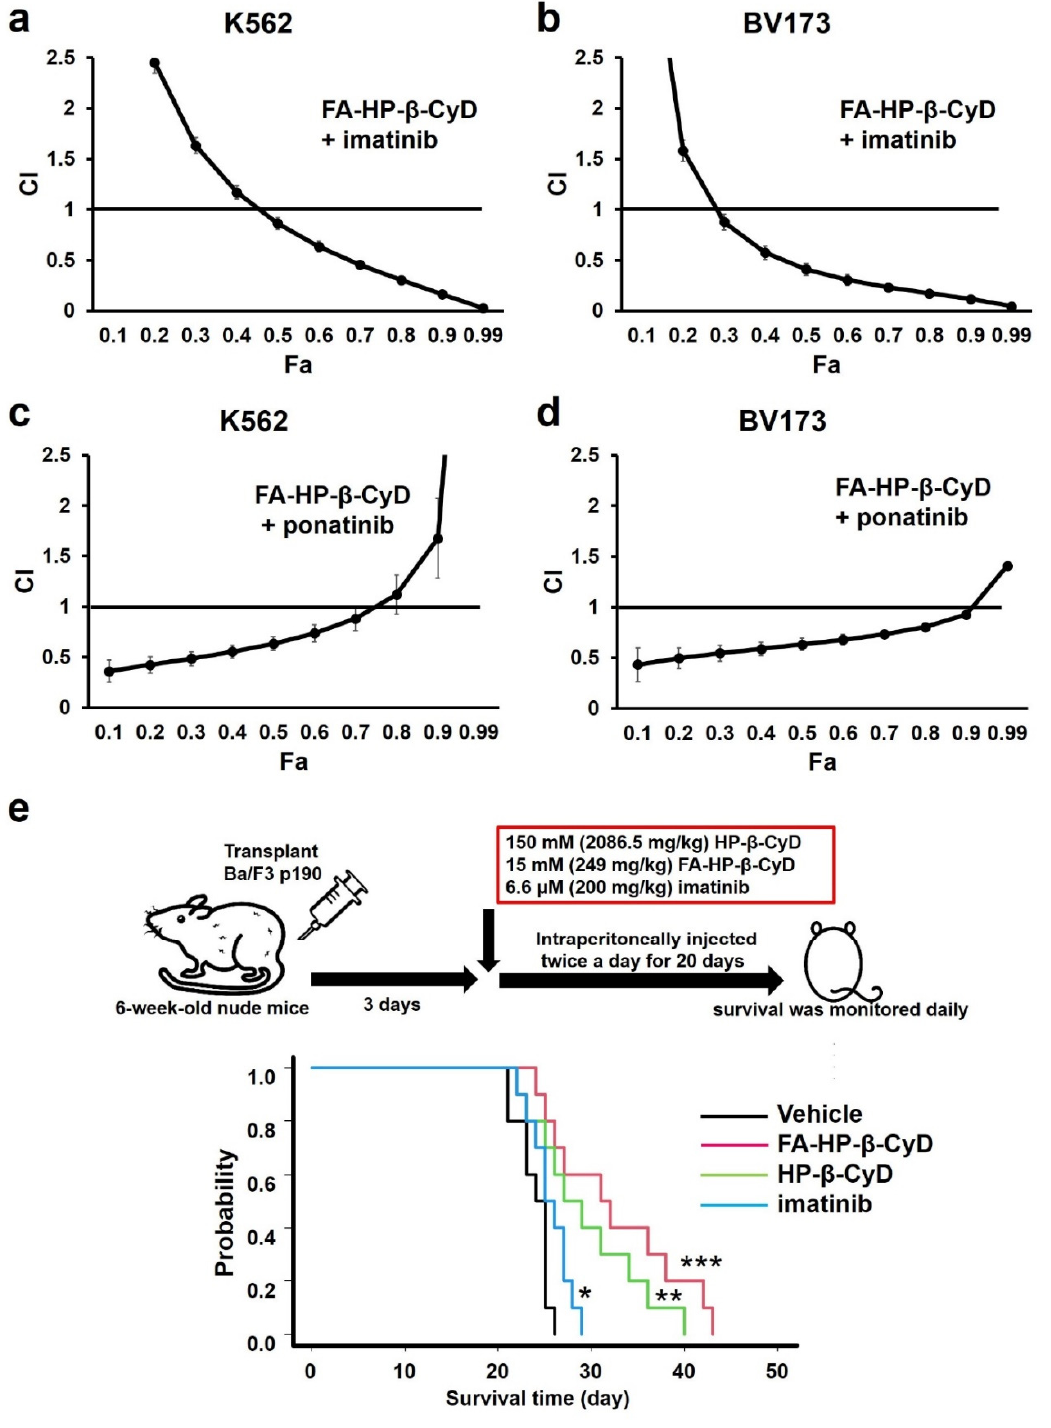
Figure 8. Evaluation of the combined effect of FA-HP- β -CyD and TKIs on CML cell lines, and effect of FA-HP- β -CyD on survival in a leukemia mouse model. ( a–d ) FA-HP- β -CyD was combined with imatinib mesylate or ponatinib. The com- bination index (CI) was calculated using Calcusyn and plotted as a function of the fraction affected (Fa). For example, 50%